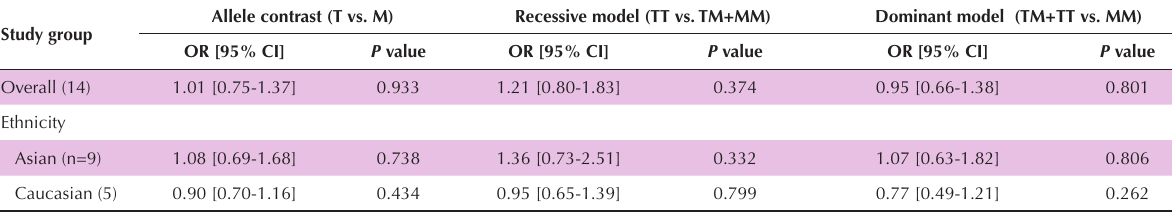
Table 2. The association between AGT M235T and DN risk in different genetic models Allele contrast (T vs. M) Study group